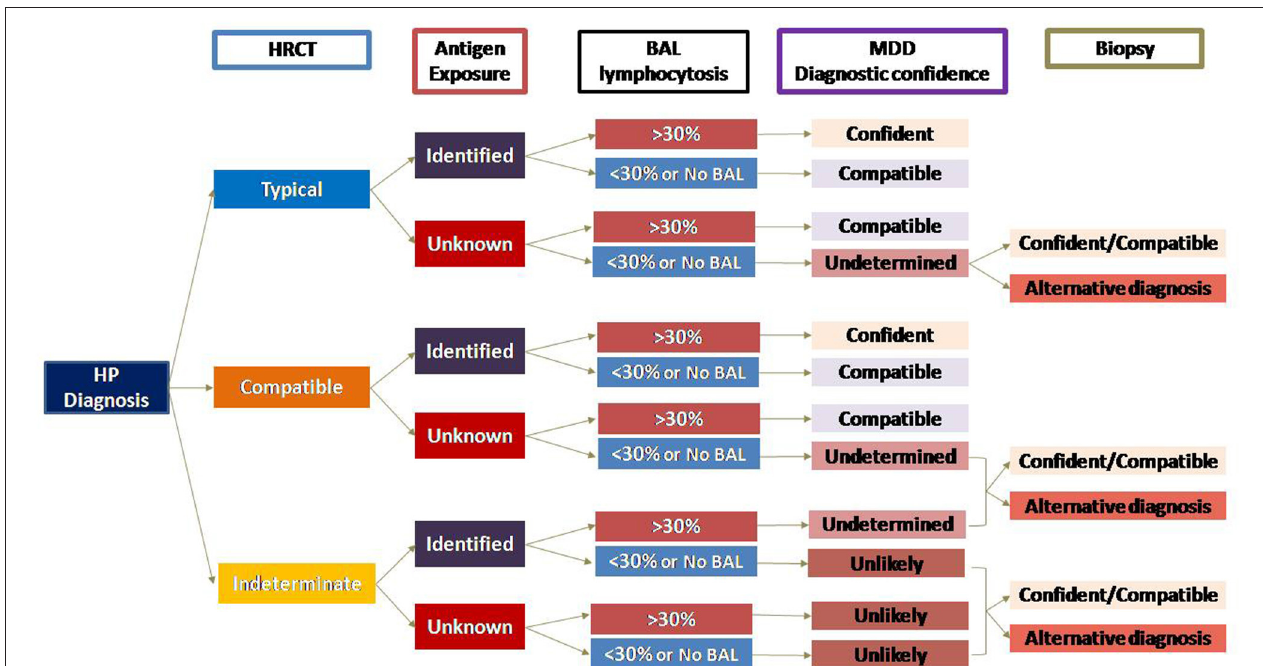
FIGURE 5 | Hypersensitivity pneumonitis diagnostic algorithm. The diagnosis of HP diagnosis relies primarily on three domains: HRCT pattern (according to ATS guideline classification), antigen exposure, and BAL lymphocytosis. This approach is followed by multidisciplinary team discussion where the diagnostic confidence is made. Undetermined or Unlikely HP may require the lung biopsy to orientate to an alternative diagnosis, or occasionally, reveal a hidden HP. Diagnostic confidence: Confident ( > 90%), Compatible (70%-89%), Undetermined (50%-69%), Unlikely ( < 50%). NO BAL (Not performed, e.g., patients with comorbidities and/or very low pulmonary function tests, patient’s refusal to do the procedure; BAL not available, or other reasons). HP, hypersensitivity pneumonitis; HRCT, high resolution computed tomography; BAL, bronchoalveolar lavage; MDD, multidisciplinary discussion.